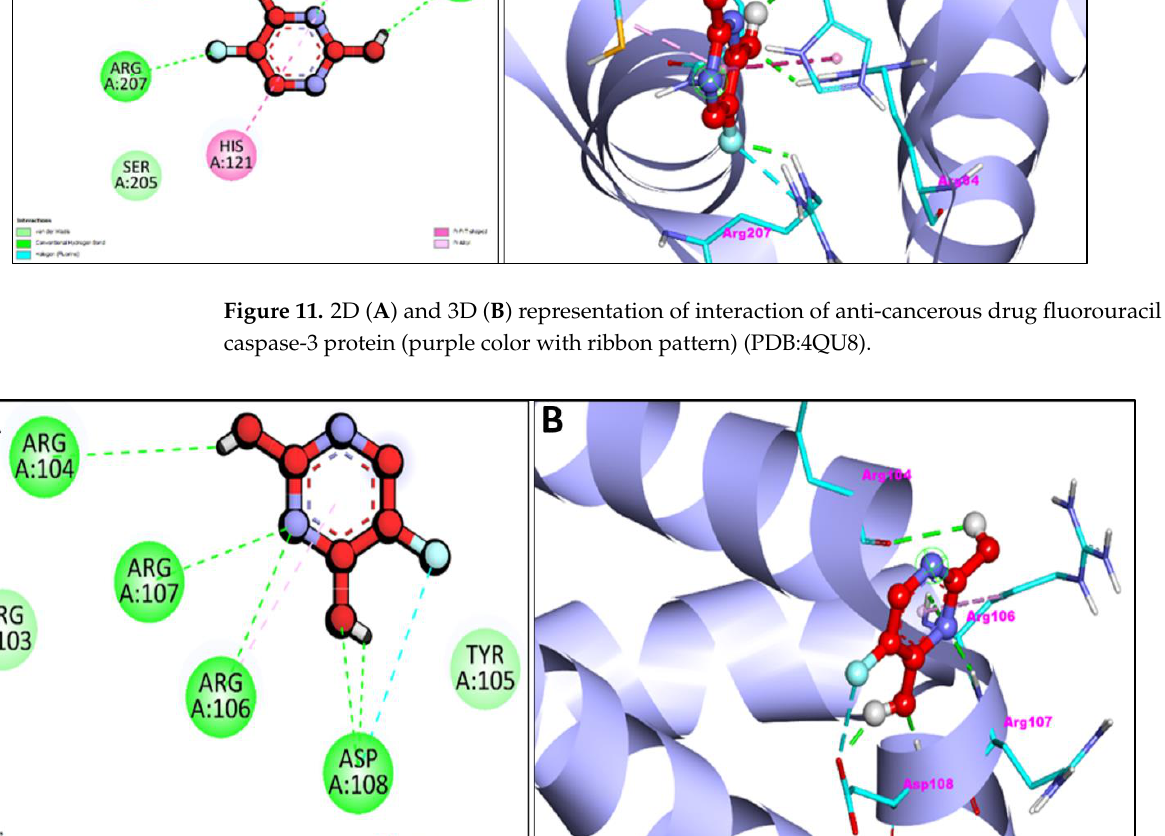
Figure 12. 2D ( A ) and 3D ( B ) representation of interaction of anti-cancerous drug fluorouracil and apoptosis regulator Bcl-2 (purple color with ribbon pattern) (PDB:4MAN).